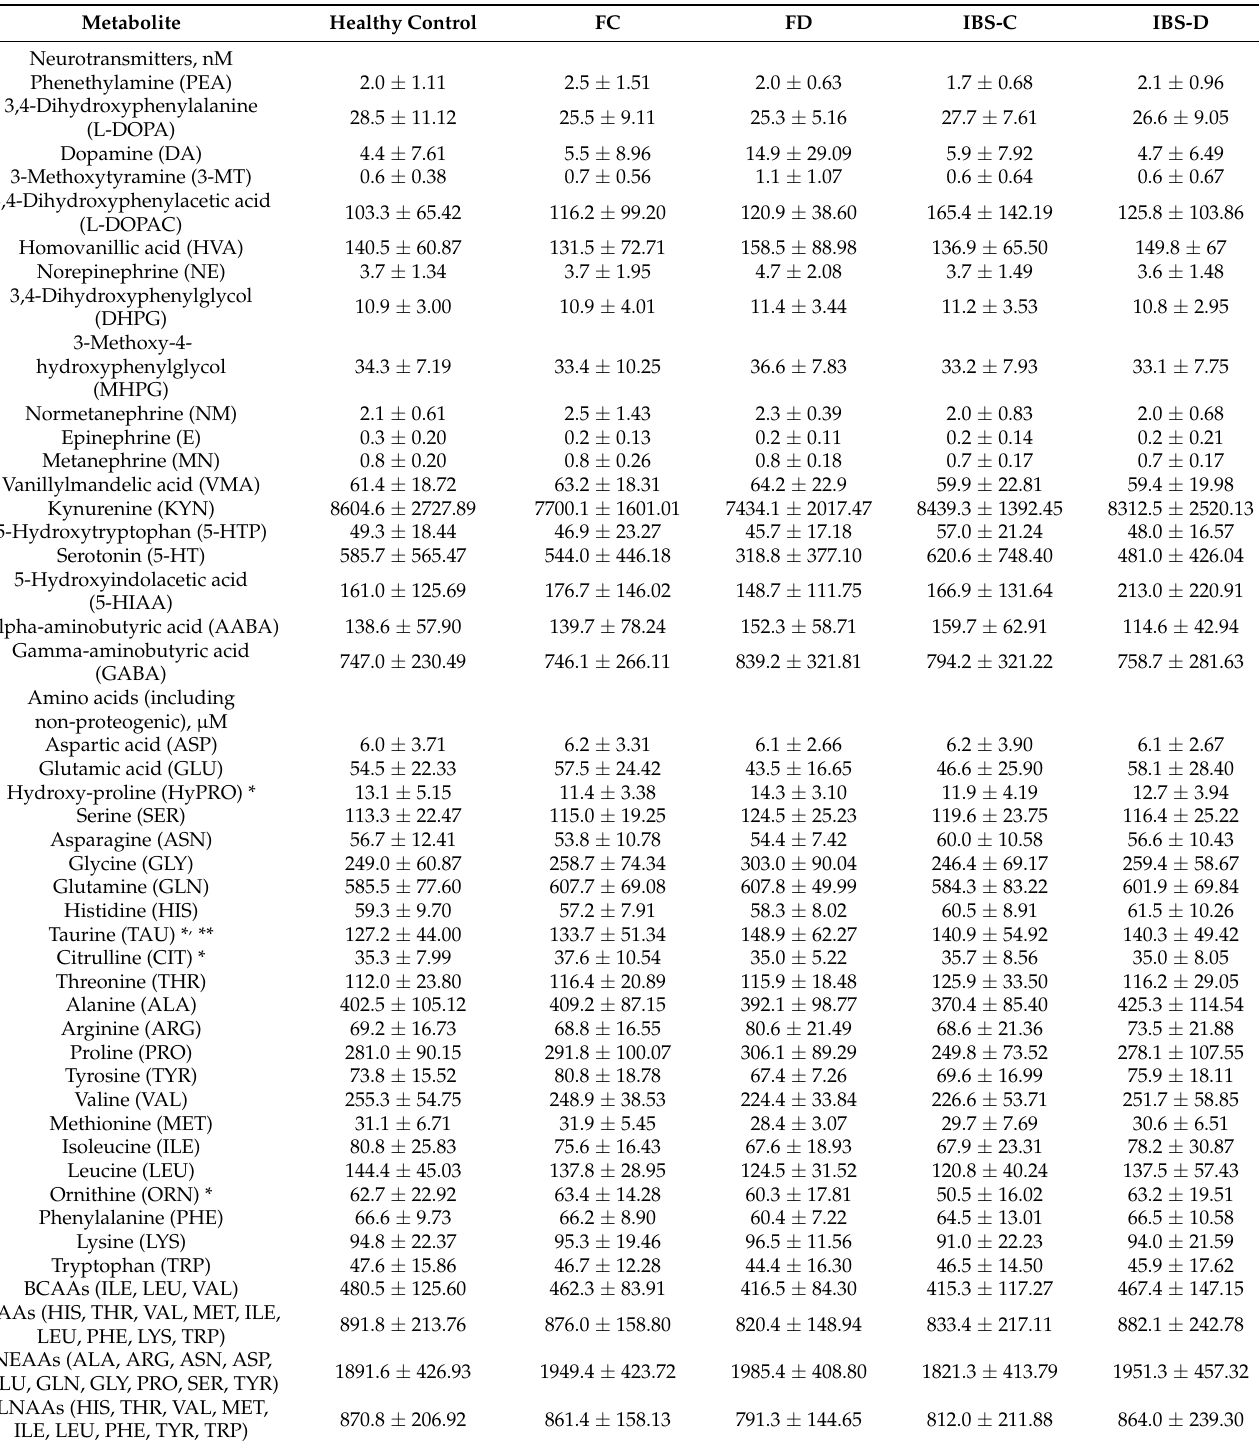
Table 2. Concentration of plasma amino acid and neurotransmitter metabolites. Mean values ± standard deviation are presented as either nM or µ M of plasma. Abbreviations: Healthy control (control), functional constipation (FC), IBS-constipation (IBS-C), functional diarrhea (FD), IBS-diarrhea (IBS-D), branch chain amino acids (BCAAs), essential amino acids (EAAs), non-essential amino acids (NEAAs), large neutral amino acids